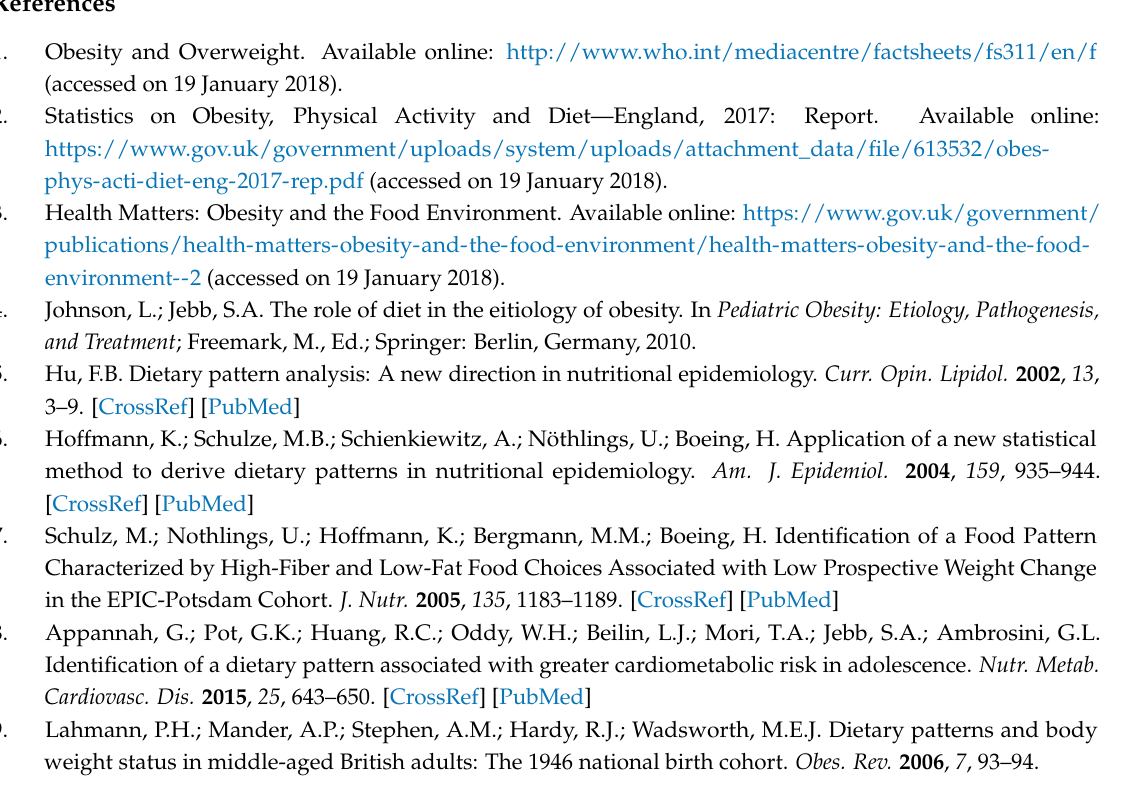
Figure S1: Dietary pattern loadings for each food group in different age groups; Figure S2: Mean dietary pattern score by each country in the UK in (a) adults (>18 years) and (b) children (<18 years); Table S1: Comparison of dietary patterns across sub-groups of the population; Table S2: Descriptive dietary characteristics by quintile (Q) of dietary pattern score in children ( ≤ 18 years); Table S3: Descriptive dietary characteristics by quintile (Q) of dietary pattern score in adults (>18 years); Table S4: Trends in dietary pattern by eating-related behaviours in children ( ≤ 18 years); Table S5: Trends in dietary pattern by eating-related behaviours in adults (>18 years); Information S1: Food groups and their contents; Information S2: Calculating a coefficient of congruence; Information S3: Code used to run RRR in